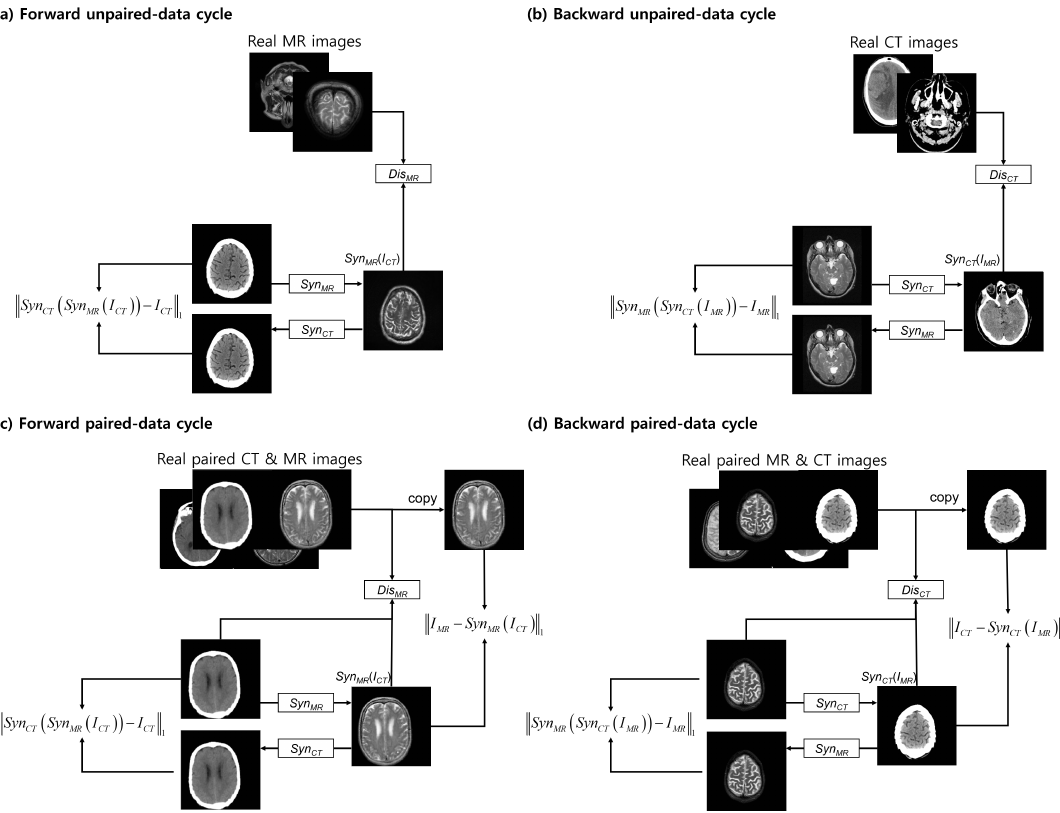
Figure 3. Dual cycle-consistent structure consists of: ( a ) a forward unpaired-data cycle; ( b ) a backward unpaired-data cycle; ( c ) a forward paired-data cycle; and ( d ) a backward paired-data